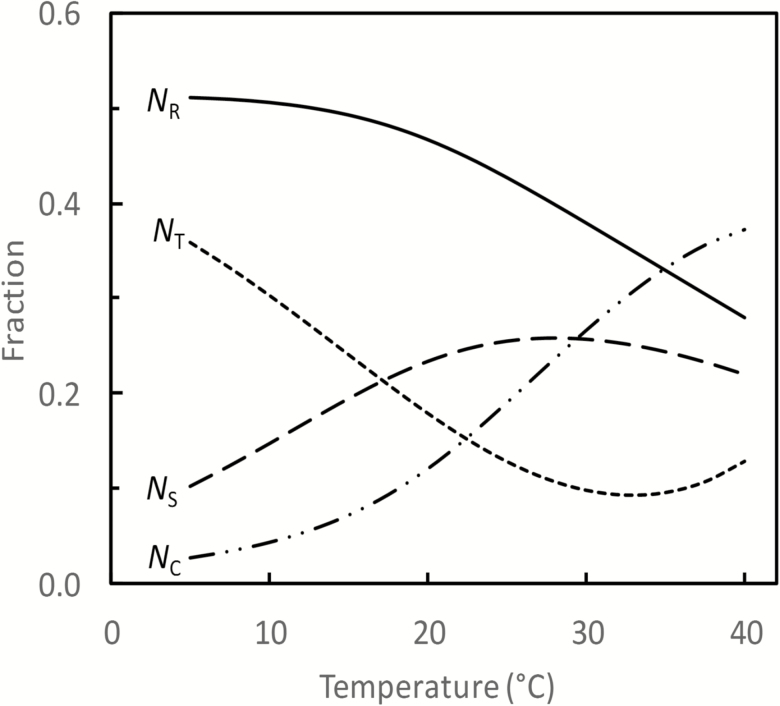
Predicted optimum partitioning of Nphoto among NC, NR, NT, and NS, as affected by leaf temperature, under the condition that Iinc = 500 µmol m–2 s–1, Cc = 250 µmol mol–1, and Nleaf = 0.15 mol m–2.